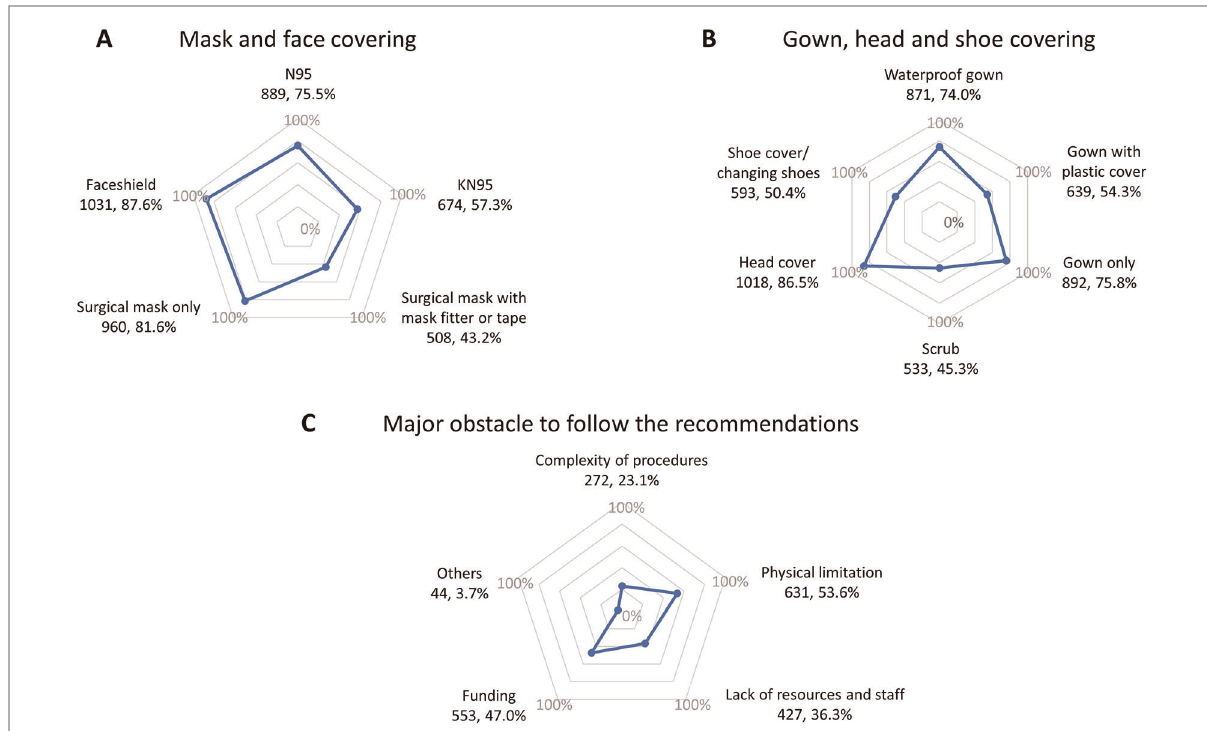
FIGURE 3 Utilization of personal protective equipment: mask and face covering ( A ); gown, head, and shoe covering ( B ). Major obstacle to following the recommendations ( C ) ( N ,